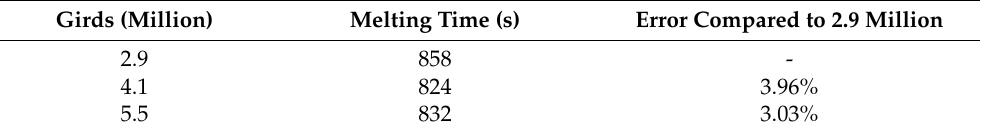
Figure 7. Temperature of T 2 at different grids. Table 2. Grid independence verification.